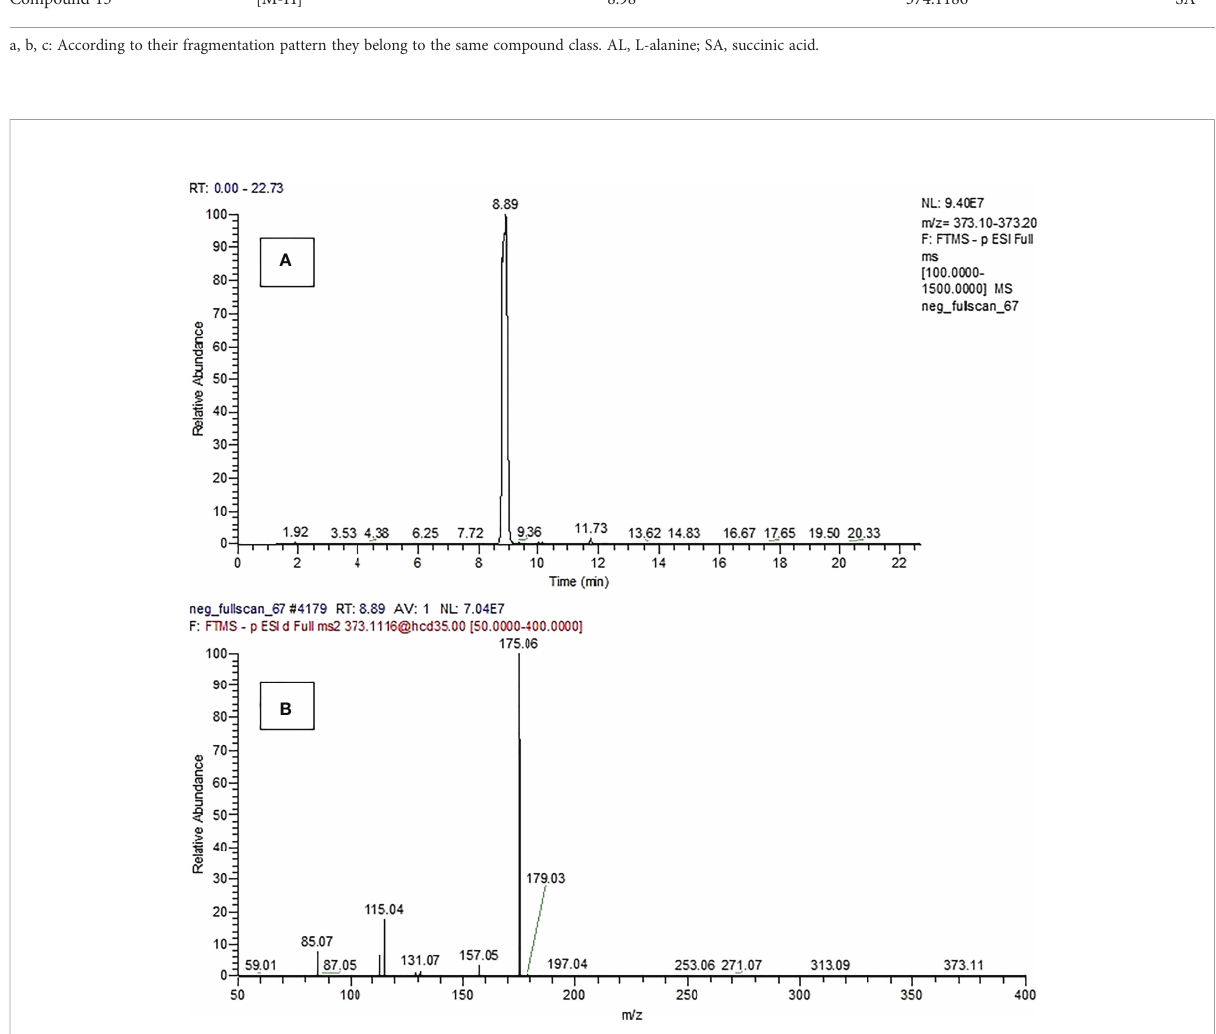
FIGURE 7 Selected ion chromatogram (A) and spectrum (B) of compound 15.